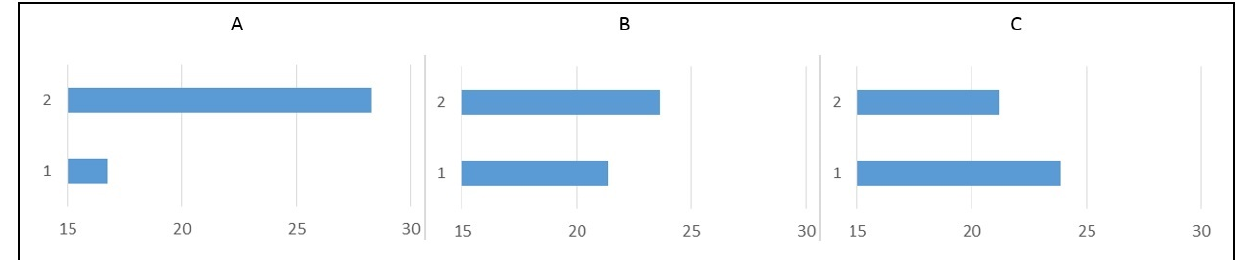
Figure 7. Graphical presentation of factors weights to measured tensile strength. ( A )—Length, ( B )—Nozzle Temperature, ( C )—Measurement temperature